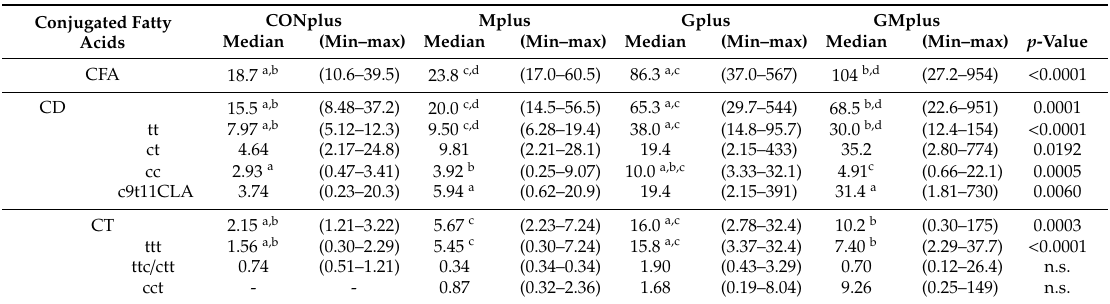
Table 4. CFA content ( µ g / g of tissue) in mammary tumours of experimental groups.